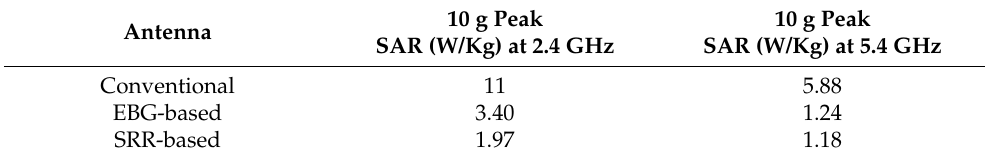
Table 8. Summary of simulated SAR normalized to 0.5 W (r.m.s.) at 2.4 GHz and 5.4 GHz.